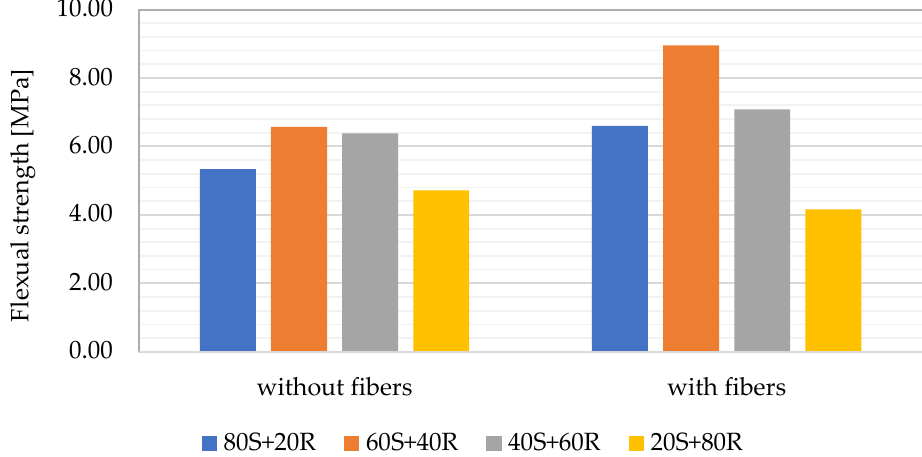
without fibers with fibers Figure 4. Comparison of the flexural strength of samples without and with WFF fibers. Figure 4. Comparison of the flexural strength of samples without and with WFF fibers. Figure 4. Comparison of the flexural strength of samples without and with WFF fibers.